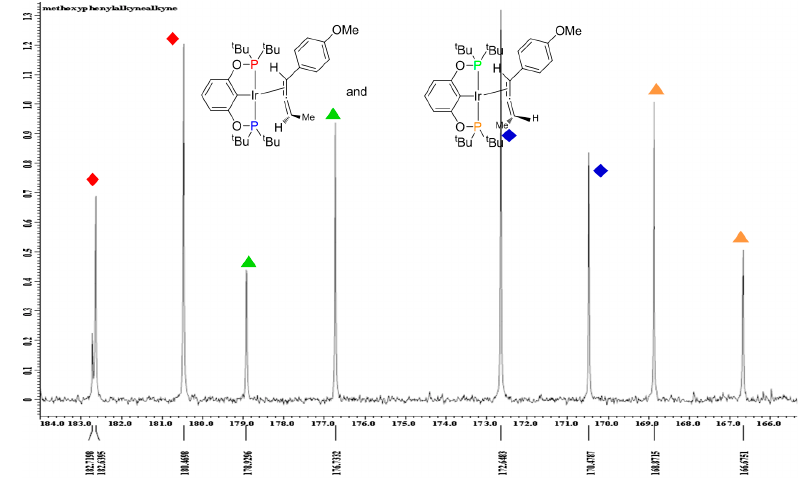
Figure 3. Partial 31 P{ 1 H}-NMR spectrum for 2b showing two diastereomers in solution.